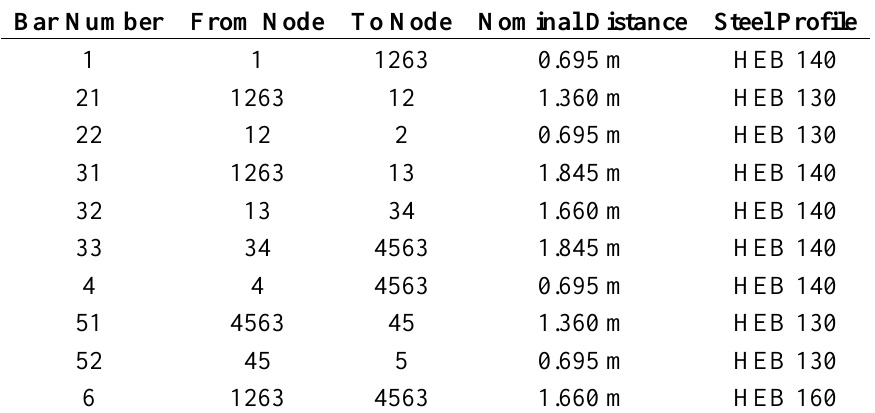
Table 1. Nominal lengths of the experimental structure.